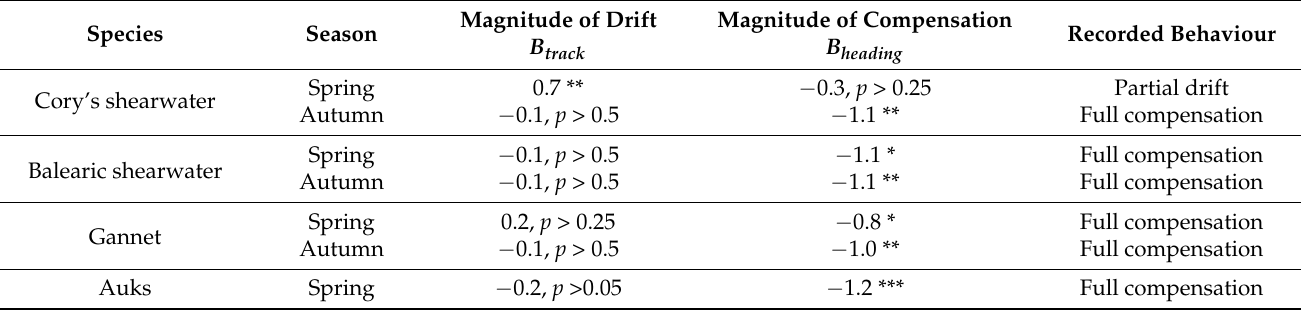
Table 3. The magnitude of drift and compensation (calculated according to Green and Alerstam [16]) for the comparison between flight directions in winds from the left and right (see text and Figure 3). When the magnitude of drift ( B track ) equals 1, there is full drift, and when it is 0, there is full compensation. Intermediate values indicate partial drift. Similarly, when the magnitude of compensation ( B heading ) equals − 1, there is full compensation, and when it is 0, there is full drift. Intermediate values indicate partial compensation. Levels of significance for tests of difference between average directions in winds from the left and right: *: p < 0.05, **: p < 0.01, ***: p <